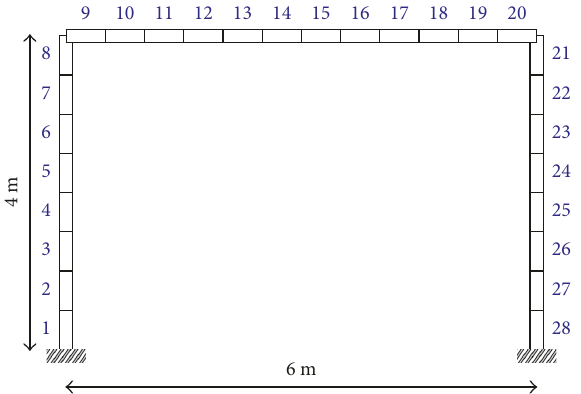
Figure 9: The frame structure under investigation.